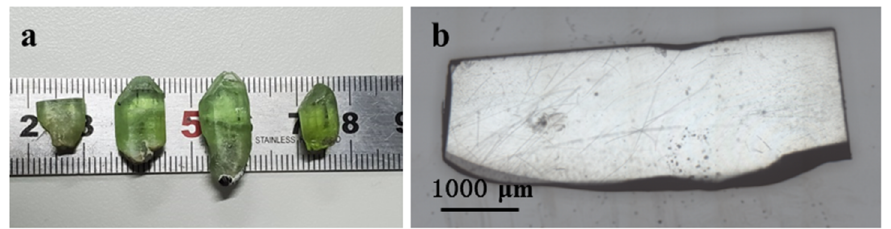
Figure 1. Optical images of ( a ) the studied forsterite crystals and ( b ) one example of the axis-oriented section.